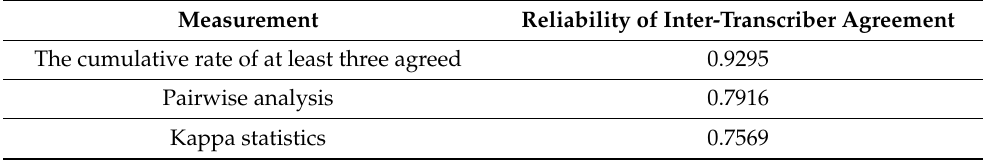
Table 7. Reliability of inter-transcriber agreement on the validation set.